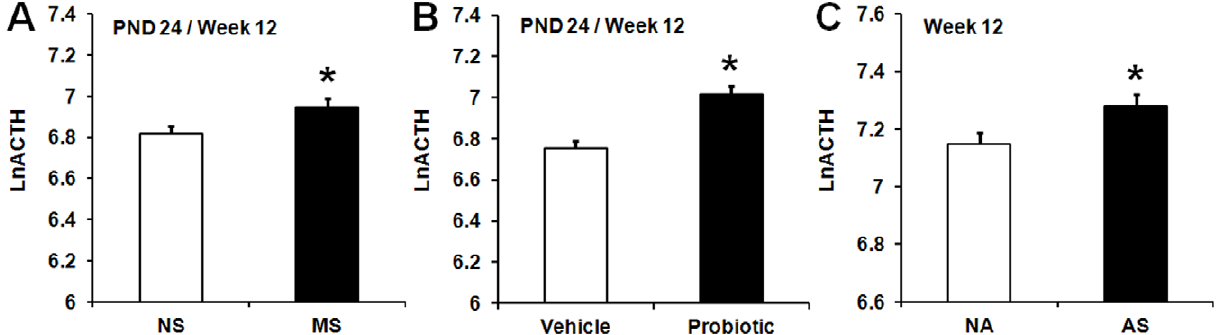
Figure 1. Effect of maternal probiotic intervention and stress on ACTH levels. A ) Effect of neonatal maternal separation (MS) on natural log transformed plasma ACTH concentrations (LnACTH, least squares means + SE). Initial ACTH data were expressed as pg/mL plasma. The filled bar represents neonatally separated animals (MS, n=107) and the hollow bar represents non-separated animals (NS, n=111). B ) Effect of maternal probiotic intervention on natural log transformed plasma ACTH concentrations (LnACTH, least squares means + SE). Hollow bar represents animals born to vehicle-treated dams (n=111). Filled bar represents animals born to probiotic-treated dams (n=107). C ) Effect of adult stress on natural log transformed plasma ACTH concentrations (LnACTH, least squares means + SE). Hollow bar represents animals exposed to no adult stress (NA, n=71). Filled bar represents animals exposed to adult stress (AS, (n=72). An asterisk (*) indicates statistical significant difference ( p # 0.05). doi:10.1371/journal.pone.0046051.g001 PLOS ONE |